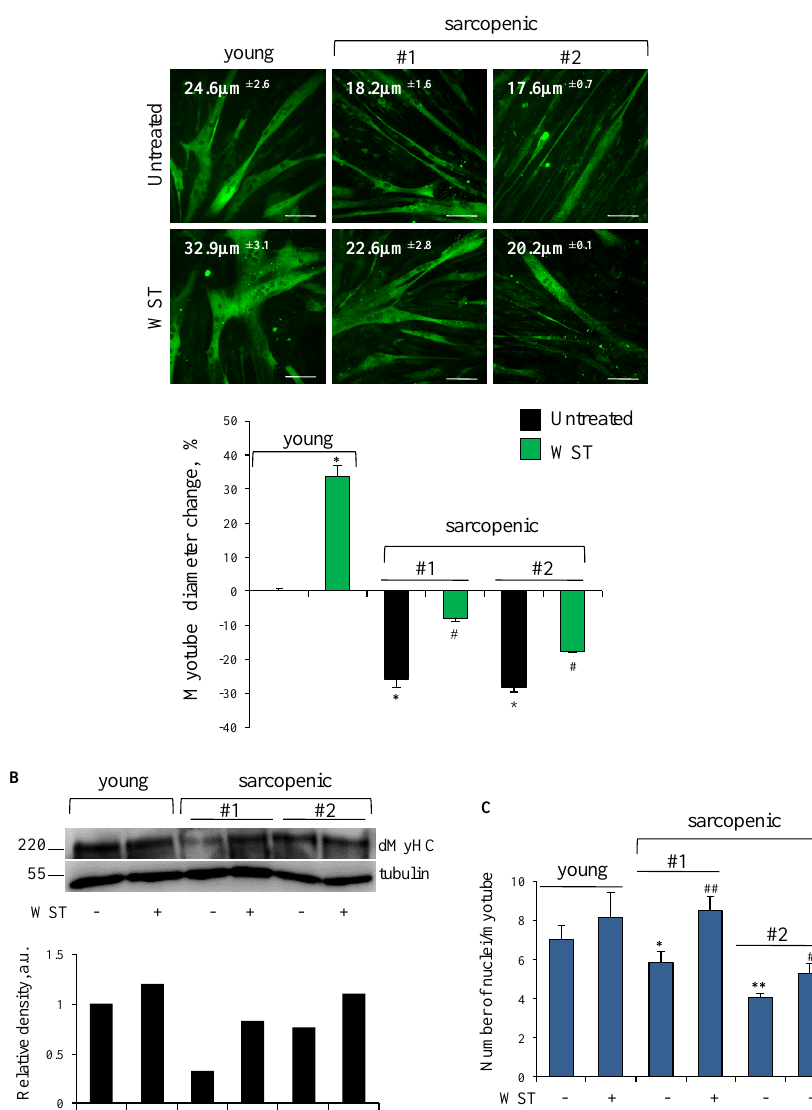
Figure 6. ( A – C ) Human myotubes obtained by culturing myoblasts derived from young and sarcopenic subjects (#1 and #2) for 4 days in differentiation medium (DM) were treated or not with WST for 48 h. ( A ) Immunofluorescence (IF) staining for myosin heavy chain (MyHC)-II was performed and myotube diameters were measured. Reported are representative images with indicated the myotube diameters ( µ m), and the percent changes of myotube diameters with respect to young untreated control. ( B ) Myotubes were lysed to analyze developmental MyHC (dMyHC) expression by WB (western blotting). Reported are representative images and the relative densities with respect to tubulin. ( C ) The average numbers of nuclei/myotube are reported. Results are means ± SEM (standard error of the mean) ( A , C ). Statistical analysis was conducted using t-test. * p < 0.05 and ** p < 0.01 significantly different from young untreated control. # p < 0.05 and ## p < 0.01 significantly different from internal control. Bars, 100 µm.